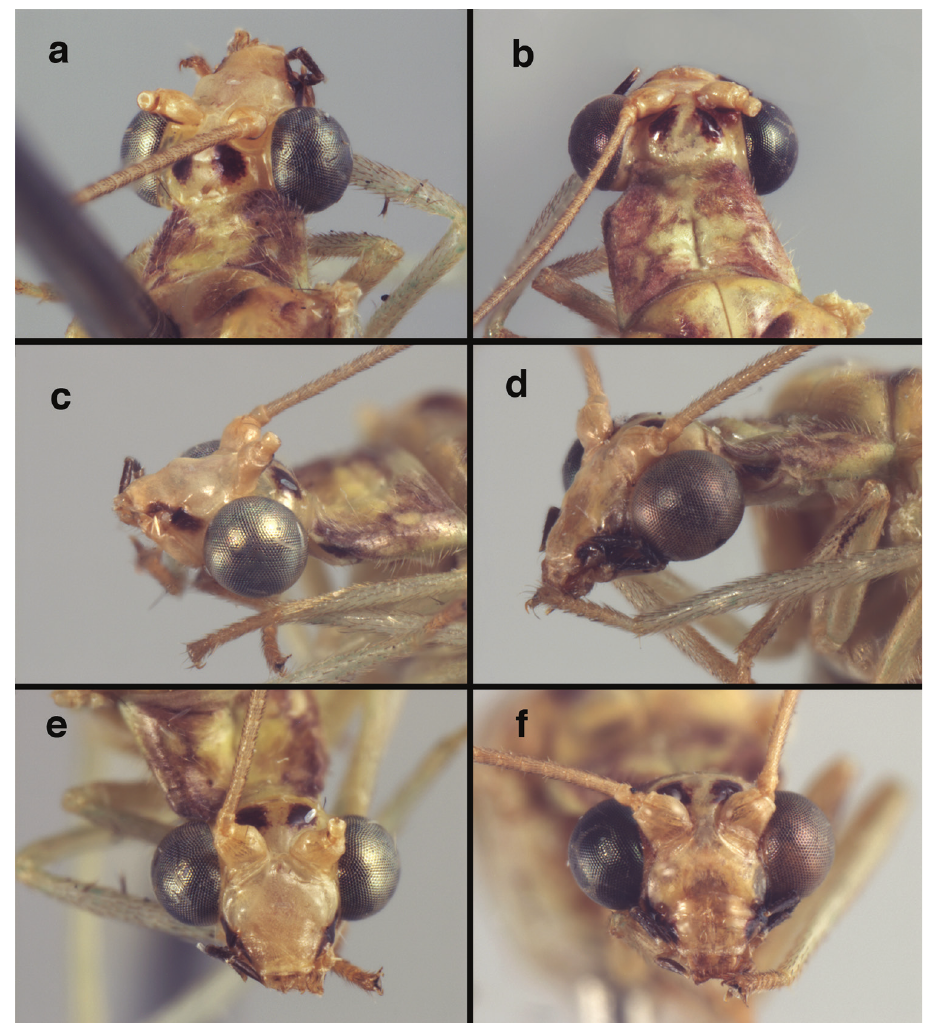
Figure 43. Ungla grandispiracula Tauber, sp. n. External features, ( a, b ) head, prothorax, dorsal ( c, d ) head, frontolateral ( e, f ) head, frontal (all: Colombia, Antioquia, USNM; a, c, e male, holotype; b, d, f female,